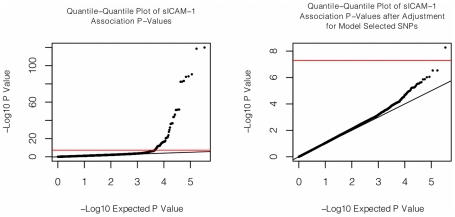
Quantile-quantile plot of association with sICAM-1.The quantile-quantile plot of sICAM-1 association P-values is shown on the left. On the right, the same quantile-quantile plot is shown, but after adjusting sICAM-1 values for the 9 SNPs retained by the model selection algorithm.